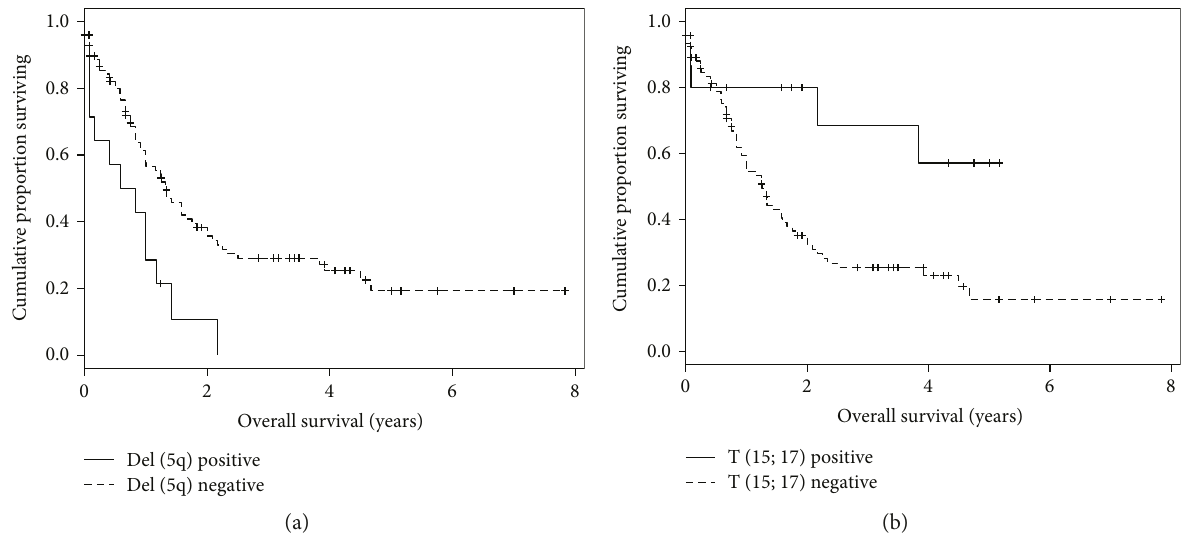
Figure 9: Kaplan-Meier survival curves. The x -axis lists survival time in years, and the y -axis represents cumulative survival proportion. (a) The survival time of 50% of the Del (5q)-positive patients is less than 1 year. (b) The survival time of 50% of the T (15; 17)-positive patients is more than 4